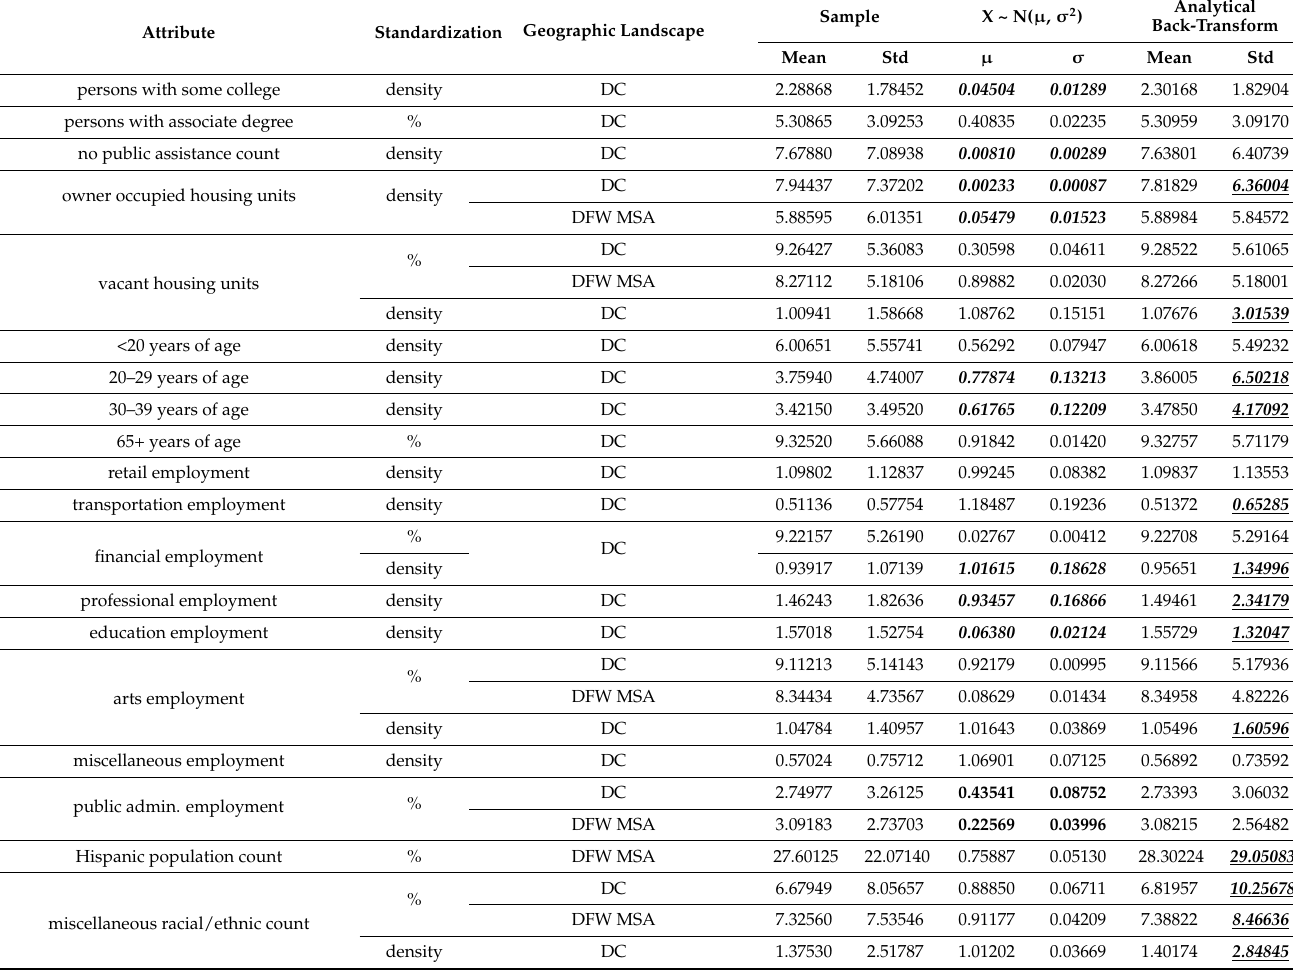
Table A3. Some relevant facets of reciprocal Box–Cox data transformation oriented attribute RVs.